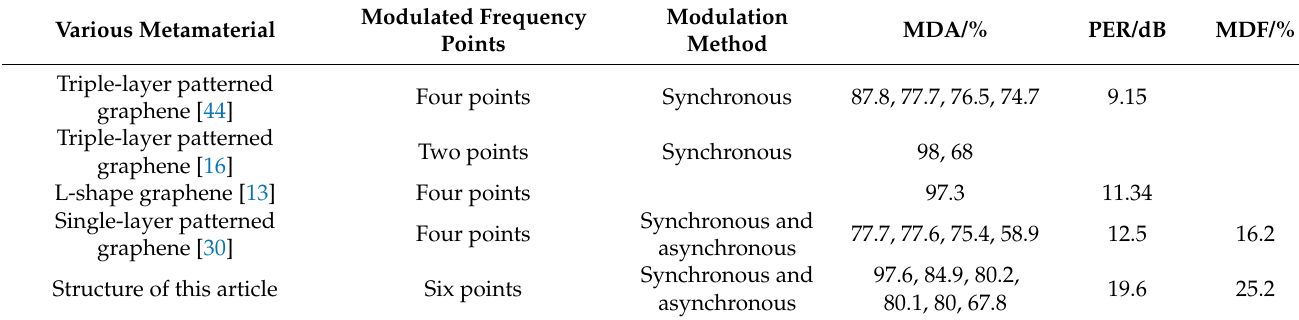
Table 1. Performance comparison of different graphene